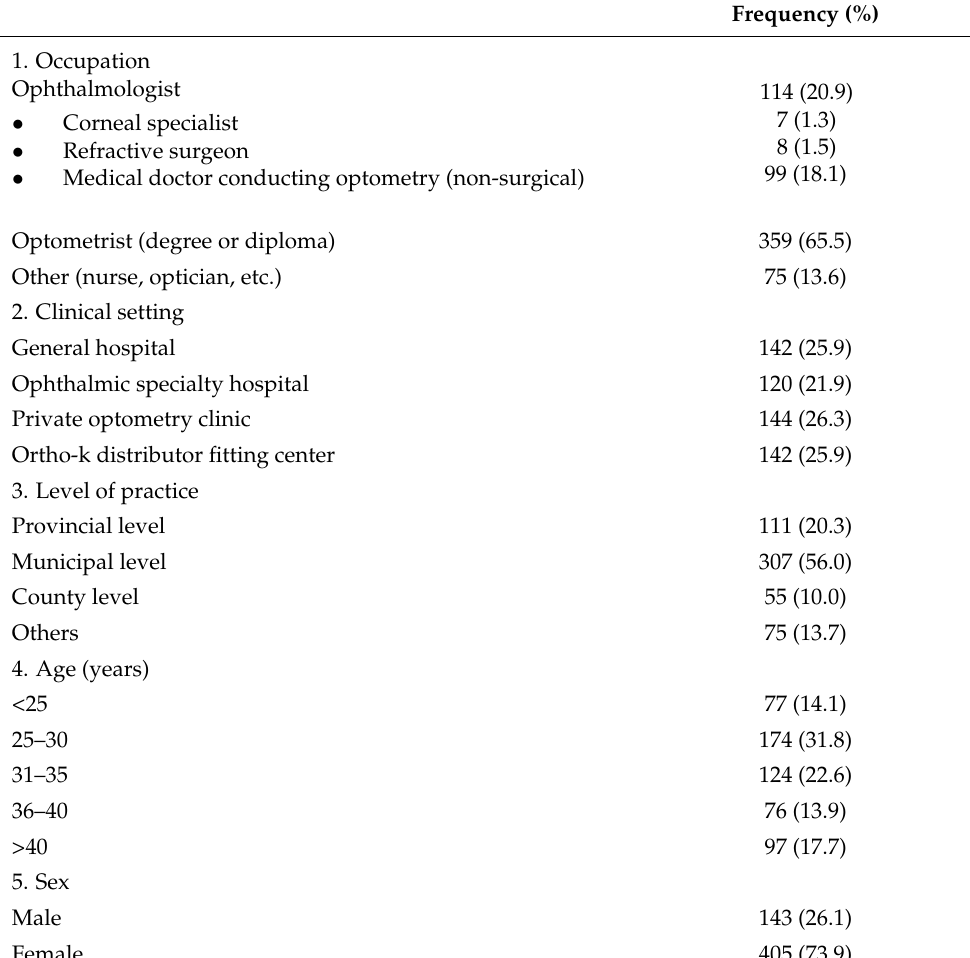
Table 2. Respondents’ knowledge and attitudes towards antibiotic eye drop use in